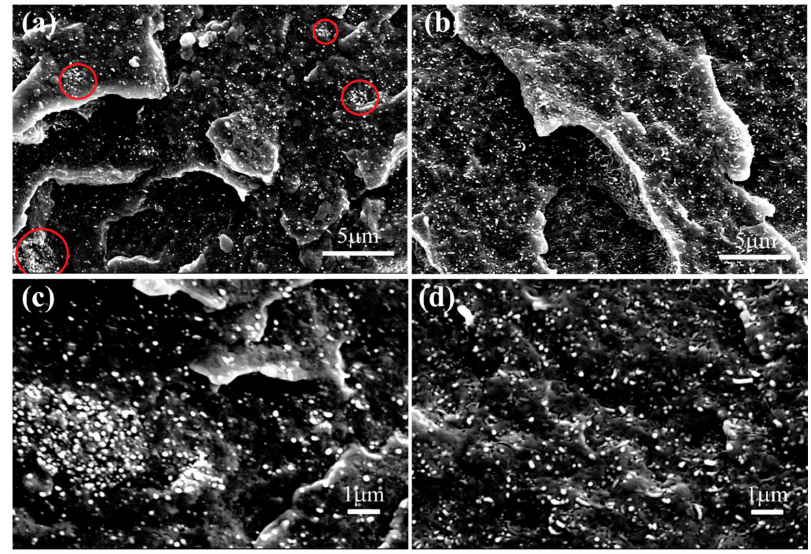
Figure 5. SEM images of the composite filled with 2.4 vol % c-MWCNTs. ( a ) c-MWCNT/PVDF composite with 5000 magnification; ( b ) c-MWCNT/MG/PVDF composite with 5000 magnification; ( c ) c-MWCNT/PVDF composite with 10,000 magnification; and, ( d ) c-MWCNT/MG/PVDF composite with 10,000